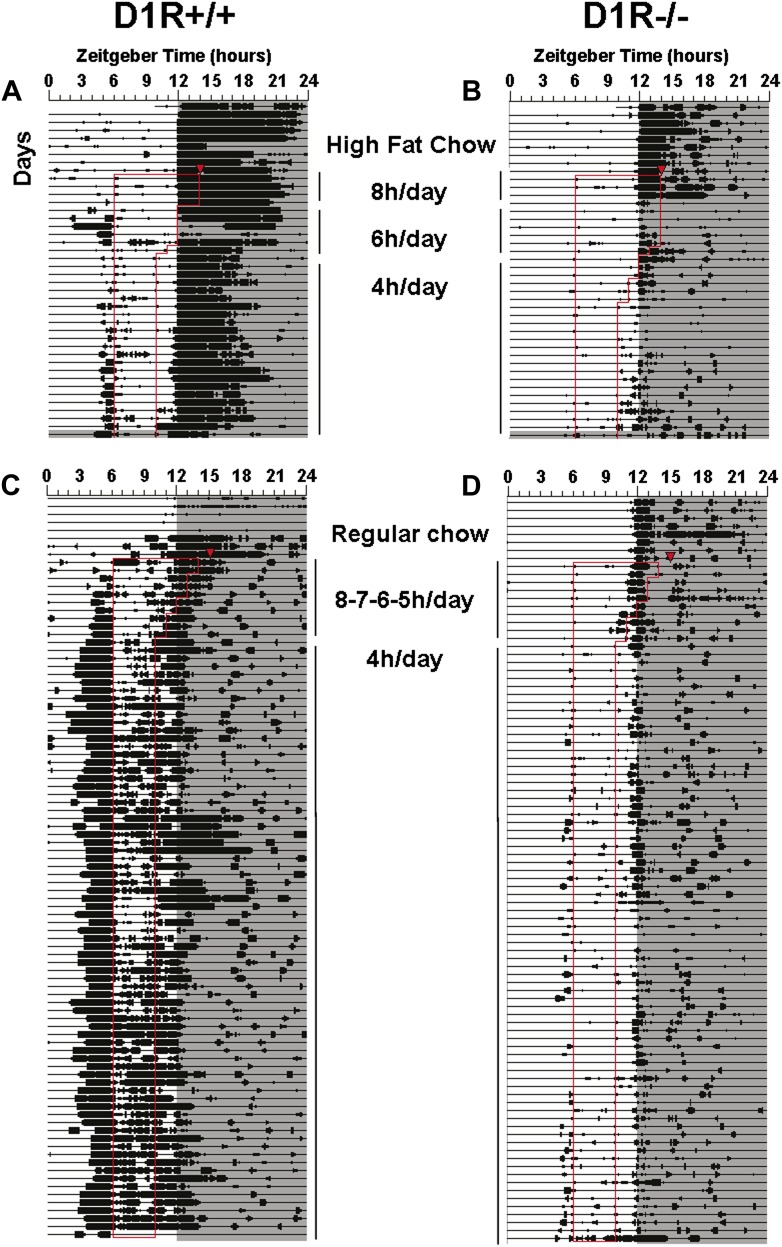
Actogram data for representative D1R knockout and control mice.Representative actograms of disc running activity in D1R WT (A and C) and D1R KO (B and D) mice. Each line represents 24 hr plotted in 10 min bins from left to right. Consecutive days are aligned vertically. Bins during which activity was registered are denoted by vertical deflections of varying height in proportion to the amount of activity. Lights-off is indicated by shading. Days of restricted feeding are indicated by the vertical thin bars to the immediate right or left of the actograms. Meal time hours are outlined by thin red lines. Food was a high fat chow (A and B) or regular chow (C and D).